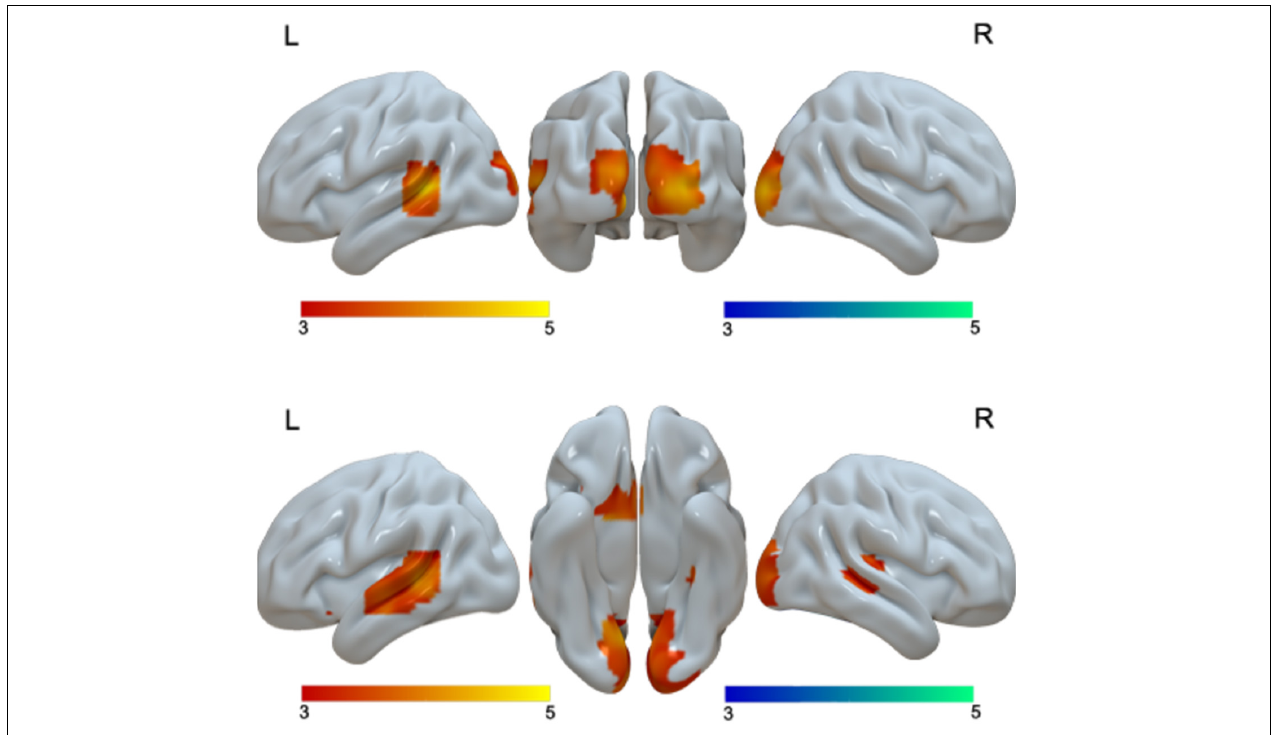
FIGURE 2 | First row, brain regions that showed greater activation in Chinese than in English for adults. Second row, brain regions that showed greater activation in Chinese than in English for children. No brain regions showed greater activation in English than in Chinese for either adults or